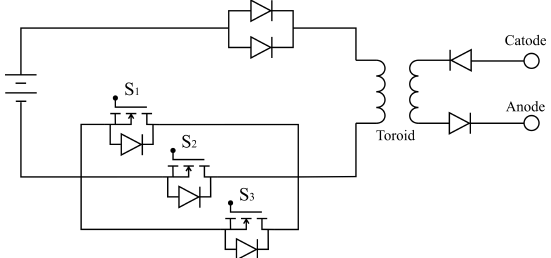
Figure 2. Schematic circuit of the inductive pulse